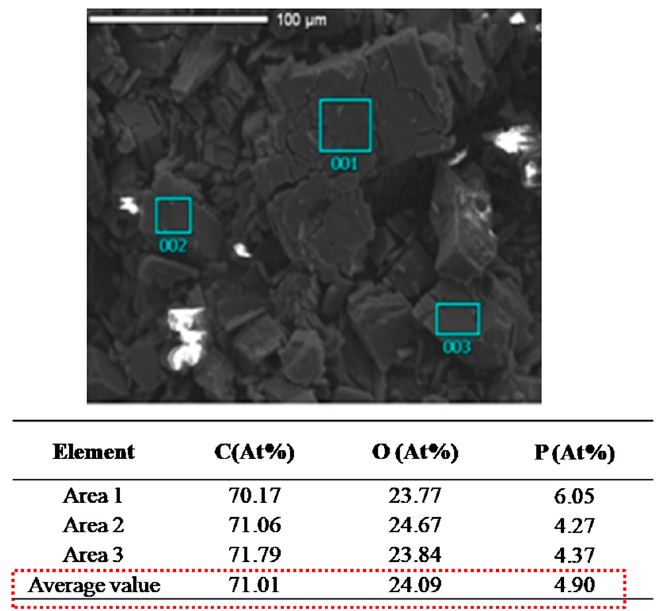
Figure 3. SEM-EDS image of IC.